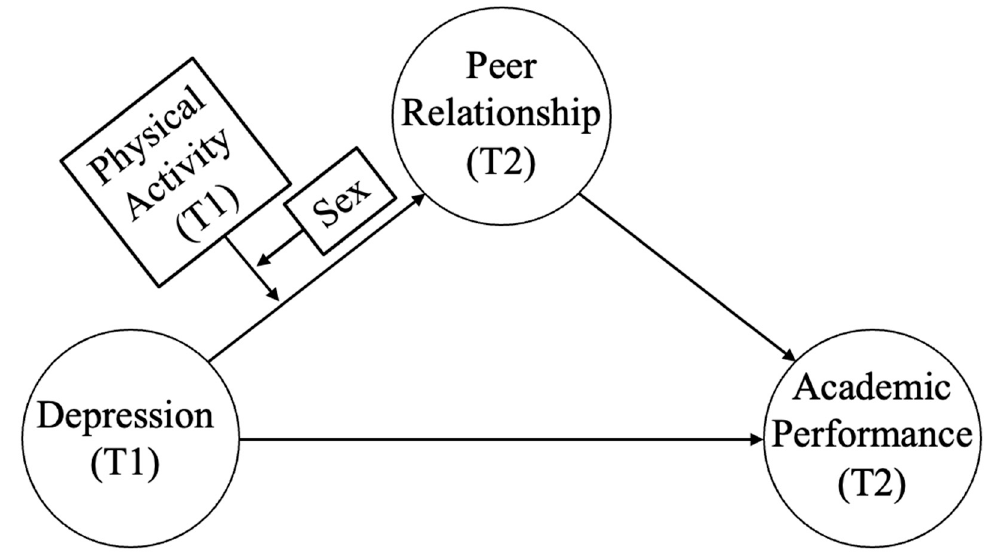
Figure 1. Moderated moderated-mediation model A (T1 represents time point 1, which represents the survey data from 2013; T2 represents time point 2, which represents the survey data from 2014).